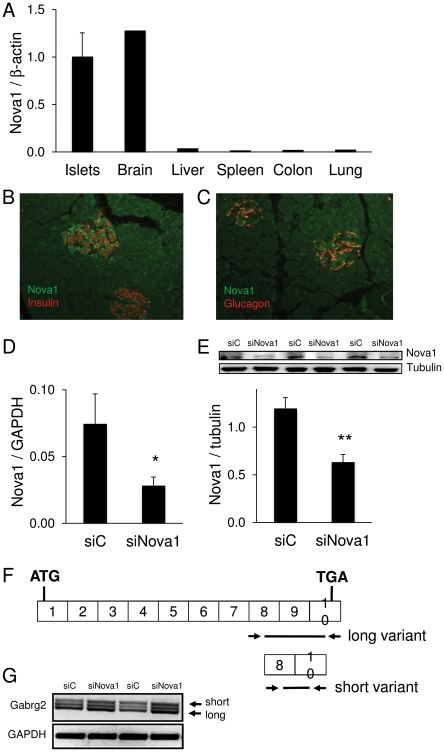
Nova1 expression and function in human pancreatic islets.(A) Nova1 mRNA expression was examined by qRT-PCR in 7 human islet preparations and human brain, liver, spleen, colon and lung tissue. Data were normalized to expression levels of the housekeeping gene β-actin. (B, C) Nova1 expression (green) was evaluated by immunofluorescence in human pancreatic sections stained for insulin (B) or glucagon (C, either hormone labeled red). The picture is representative of 3 independent experiments. (D–G) Splicing by Nova1 was examined in INS-1E cells transfected with control (siC) or Nova1 siRNA (siNova1). Efficient Nova1 knockdown was shown by qRT-PCR (D) and Western blot (E) (n = 3). (F) To evaluate the splicing function of Nova1, RT-PCR was performed in siC and siNova1 transfected INS-1E cells, using primers flanking exon 9 of Gabrg2. (G) Nova1 knockdown, expected to lead to less exon 9 inclusion, increased the abundance of the short Gabrg2 transcript variant. The picture is representative of 3 independent experiments. *p<0.05, **p<0.01.